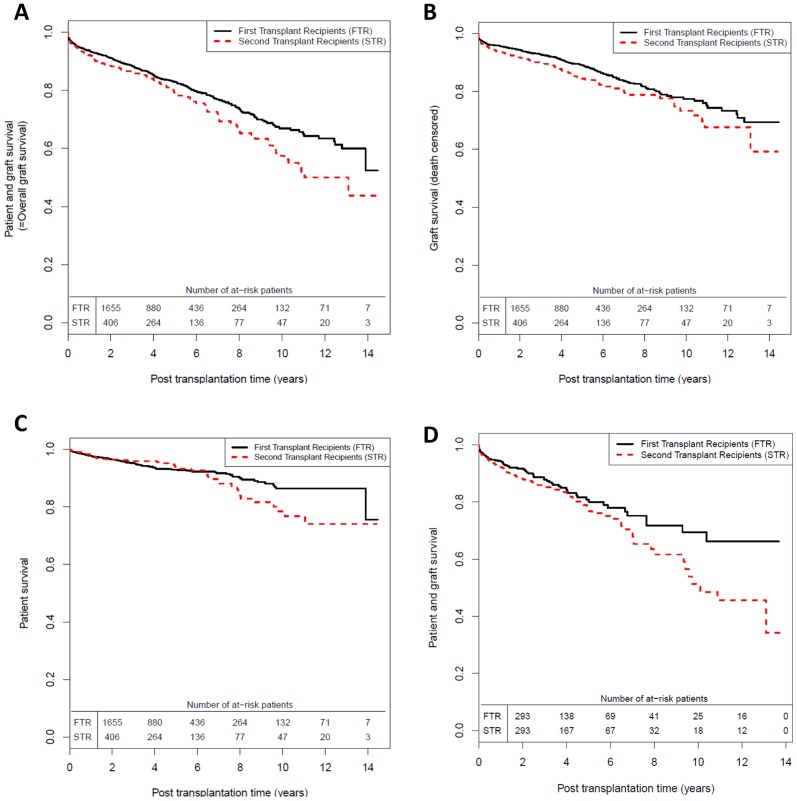
Unadjusted patient and/or graft survival analysis.(A) Patient-and-graft survival ( = overall graft survival) : patient deaths with a functioning graft are considered as a graft failure (log-rank test: p = 0.0127) (B) Death-censored graft survival: patient deaths with a functioning graft are censored (log-rank test: p = 0.0206) and (C) Patient survival: returns to dialysis are censored (log-rank test: p = 0.2890), for first and second grafts performed in the DIVAT network between January 1996 and November 2010 (Kaplan-Meier estimates). (D) Patient-and-graft survival sub-analysis for a sample of matched first grafts (N = 486) and second grafts (N = 486) for the following risk factors of graft failure: transplantation period, recipient age, history of cardiac disease, anti-class I PRA, recipient/donor relationship, BMI and EBV serology.